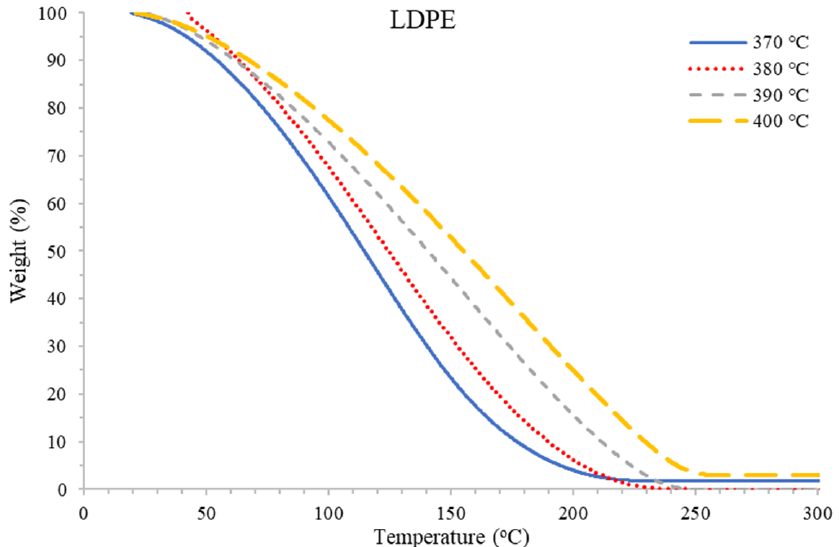
Figure 5. Representative TGA thermograms for PDFO for HDPE waste ( top ) and LDPE waste ( bottom ) as a function of temperature.